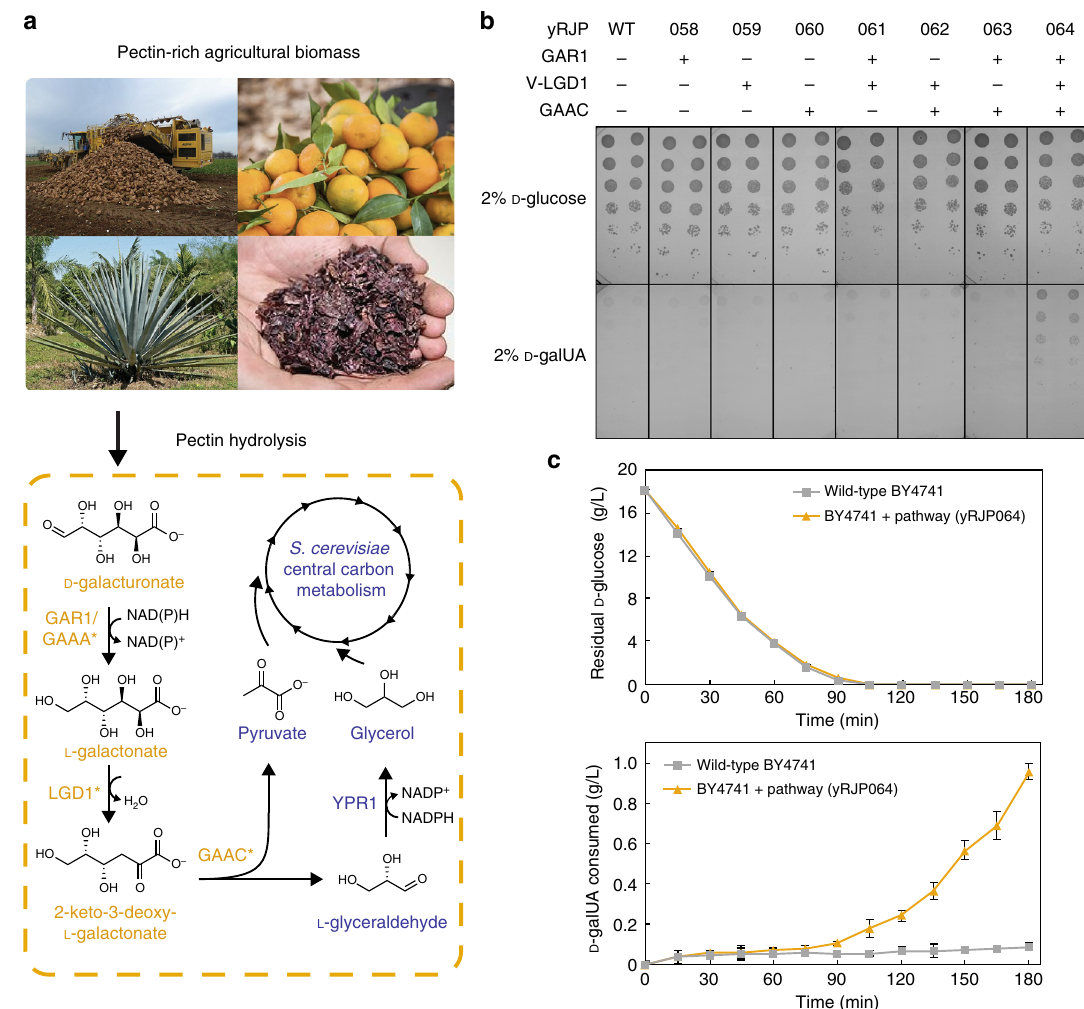
Fig. 1 Utilization of D -galacturonic acid by engineered S. cerevisiae . a Pectin-rich agricultural byproducts include sugar beet pulp, citrus peels, agave pulp and grape pomace. Hydrolysis of pectin yields D -galacturonic acid ( D -galUA) monomers. The D -galUA catabolic pathway from fi lamentous fungi (orange asterisks) can be heterologously expressed in S. cerevisiae to yield intermediates in native metabolism (blue). b Expression of high activity GAR1, Venus- LGD1, and GAAC are necessary and suf fi cient for S. cerevisiae growth on D -galUA minimal media plates. Serial spotting of S. cerevisiae strains expressing all combinations of D -galUA catabolic enzymes on D-galUA minimal media plate at pH = 3.5. c Wild-type (gray squares) and yRJP064 (orange triangles) cultures were incubated in pH 3.5 orange peel hydrolysate media at high density (OD 600 = 75) and concentrations of D -galUA and D -glucose were monitored by HPLC. Consumption of D -galUA (14.1g/L starting concentration) by yRJP064 coincides with depletion of D -glucose in media. Images